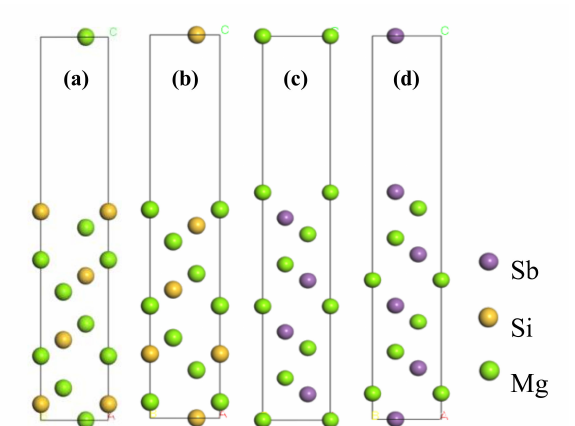
Figure 3. Four-surface model of ( a ) Si-terminated Mg 2 Si (111) slab, ( b ) Mg-terminated Mg 2 Si (111) slab, ( c ) Mg-terminated and Mg 3 Sb 2 (0001) slab, and ( d ) Sb-terminated Mg 3 Sb 2 (0001)